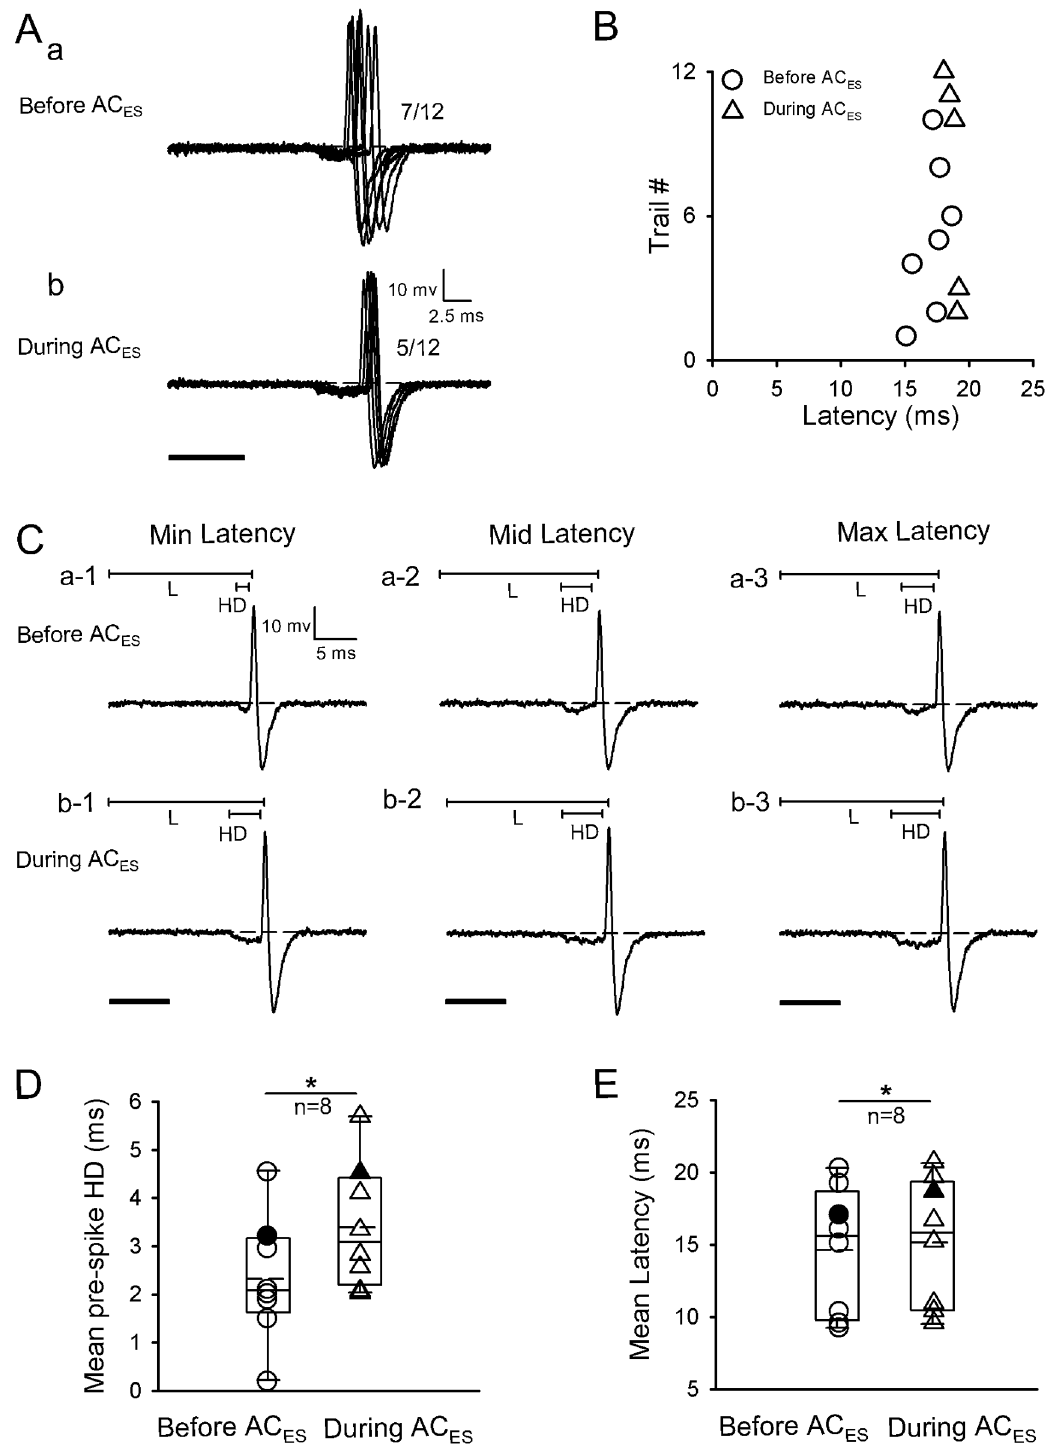
Fig 6. Representative inhibited IC neuron by AC ES showing its latency increasing induced by pre-spike HD lengthening. Originalresponse traces obtainedby 12 repetitive pure tone stimulation conditionsbefore (Aa) and during (Ab) AC ES . (B) Distributionof latency values calculatedaccordingto Aa and Ab before (unfilledcircle) and during(unfilled